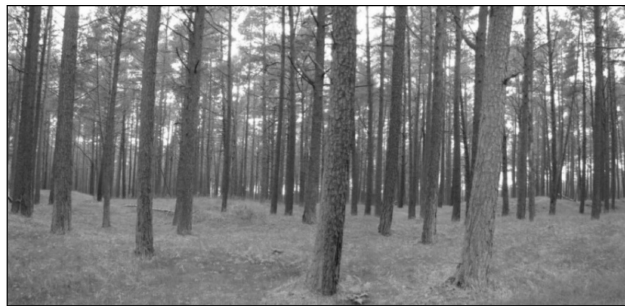
Figure 9. Mature Scots pine wood (photo by Arvydas Urbis).